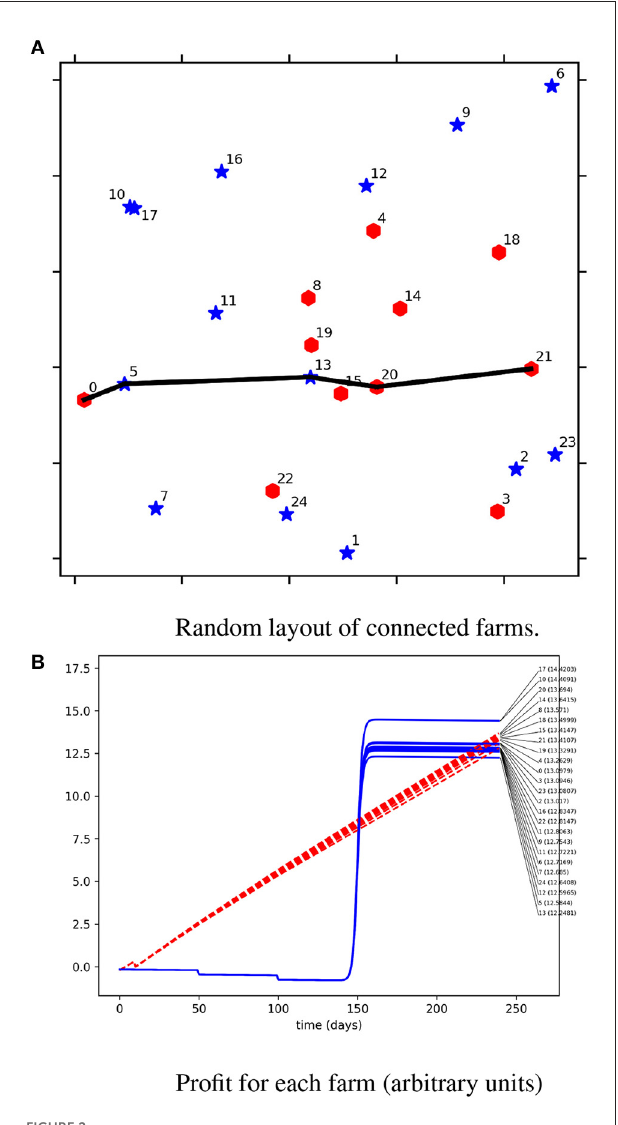
FIGURE3 Measuring the effect of the actions on each farm after 240 days and the long lasting effects seen in the landscape. In each picture, the interactions between farms are positive and it is particularly clear in the case of red hexagons the beneficial effect of being close to neighbors that manage their farm in the same way. Actions were performed on day 10 in (A) and days 50 and 100 in (B)